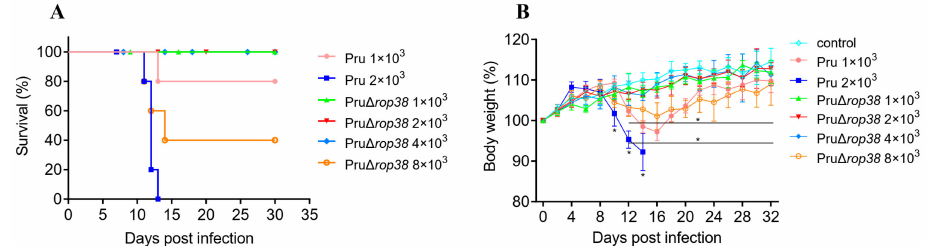
Figure 1. Pathogenicity of Pru ∆ rop38 in mice. ( A ) Survival rate and ( B ) body weight gain of CD- 1 mice infected with the parental Pru strain or the Pru ∆ rop38 strain. Pru (1 × 10 3 and 2 × 10 3 ) or Pru ∆ rop38 (1 × 10 3 , 2 × 10 3 , 4 × 10 3 , and 8 × 10 3 ) tachyzoites were injected intraperitoneally (i.p.) into mice ( n = 5), and daily monitoring of mice for 30 days (presented as the mean of body weight ± SD; * p < 0.05; one-way ANOVA with